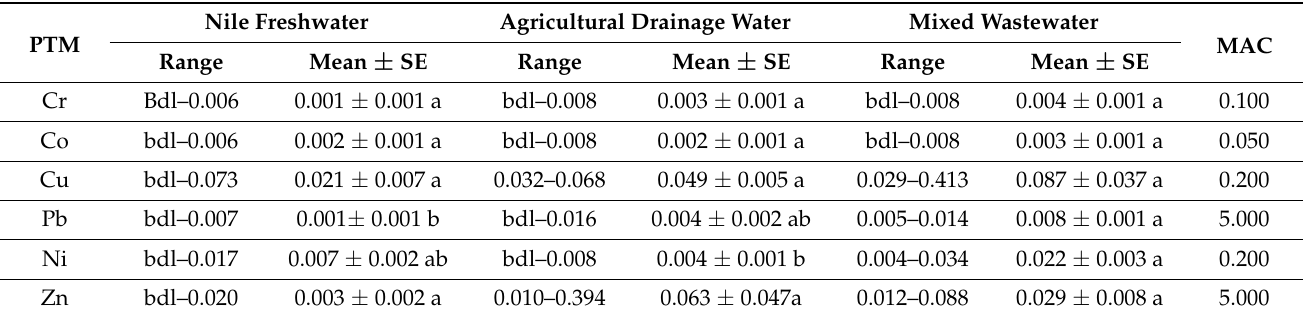
Table 2. Concentrations of PTMs (mg L − 1 ) in irrigation water.